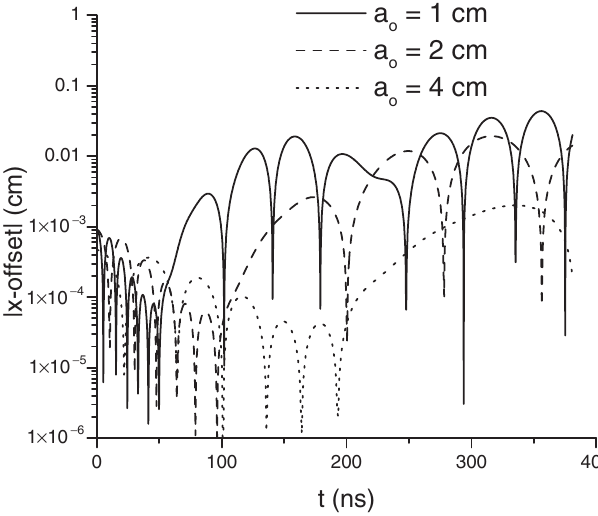
FIG. 9. Model predictions of hose growth with different beam radii for a beam slice that is 210 cm from the beam head. For (cid:6) 1 GeV , (cid:13) (cid:6) 30 cm , A (cid:6) 0 : 001 , and a these calculations E b p 3:1 detuning ratio is used.